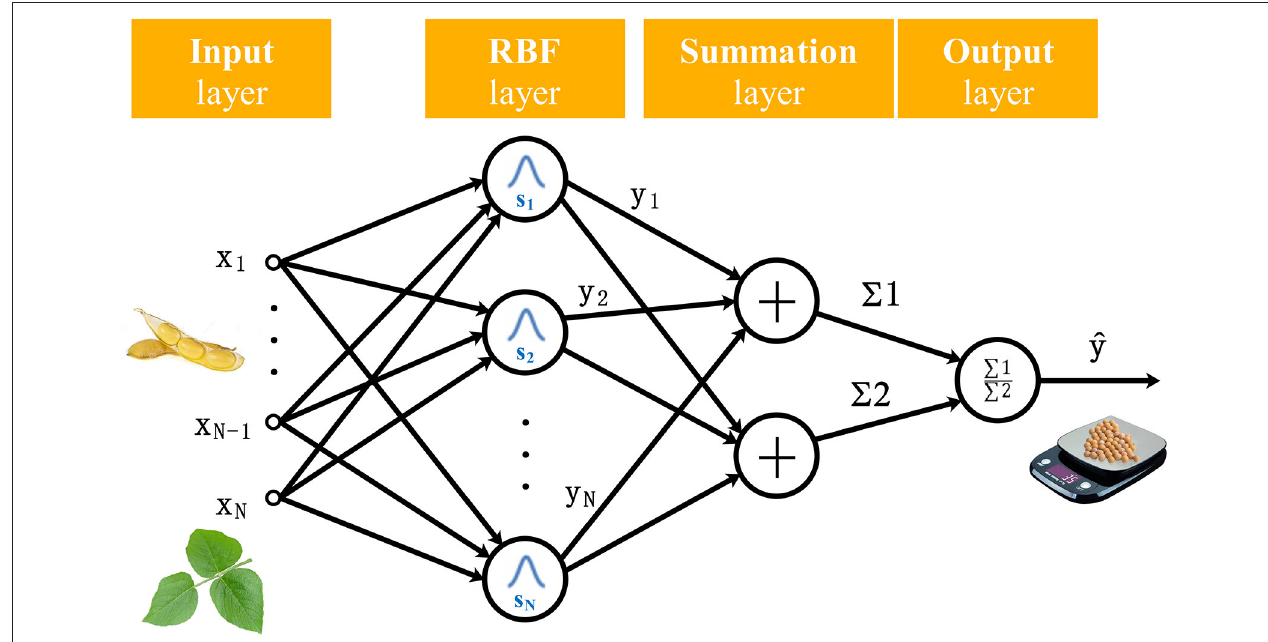
FIGURE 6 | Architecture of soybean yield prediction model of GRNN.